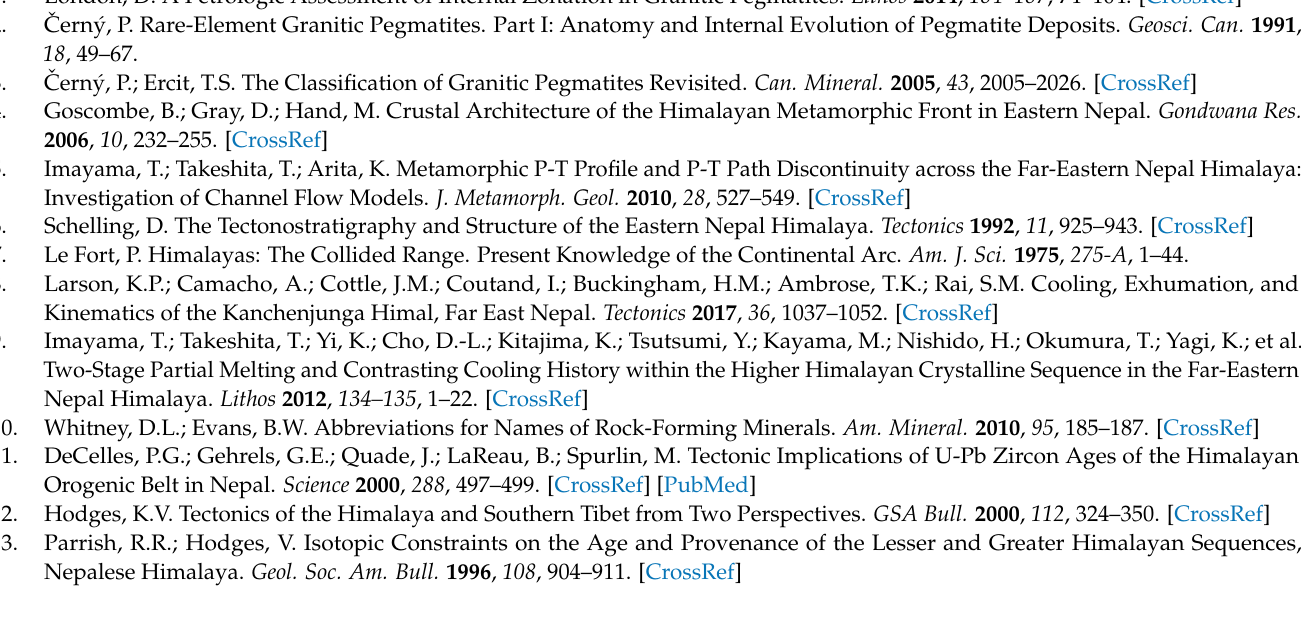
Table S5: The LA-ICP-MS trace element composition of muscovite from the Yamrang Pegmatite, Ikhabu Pegmatite Field (IPF), Eastern